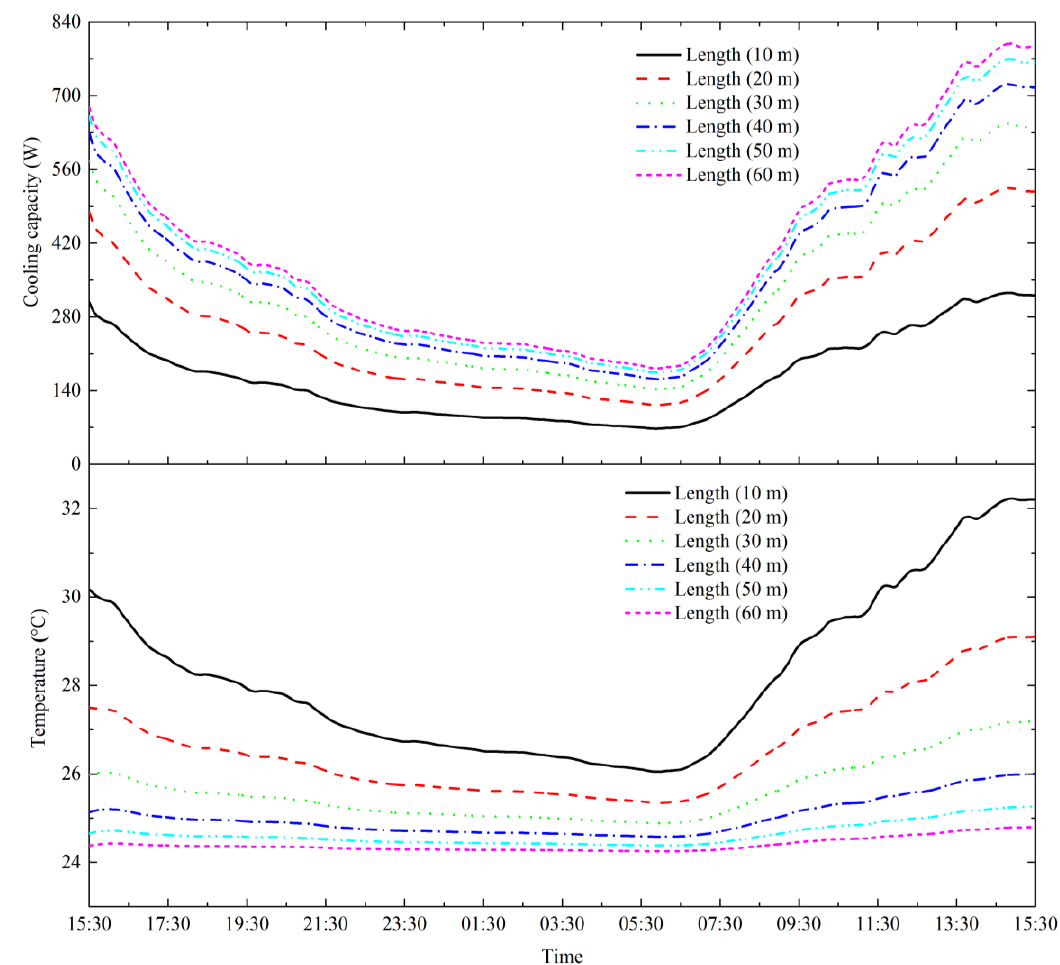
ff ect of di ff erent tube lengths on the cooling capacity and the outlet Figure 6. The effect of different tube lengths on the cooling capacity and the outlet temperature. Figure 6. The e